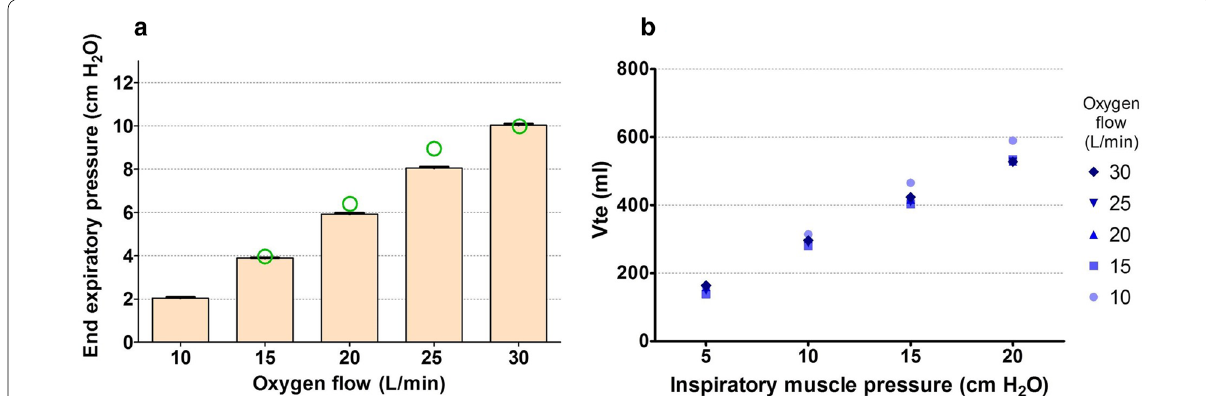
Fig. 1 Bench study and physiological measurements. Changes in pressure and volume related to the oxygen flow rate. a Mean (bar chart) standard deviation (error bar) of end expiratory pressure recorded on the oro‑nasal mask of Boussignac FF‑CPAP assembled with the DAR ± filter (see text), obtained at five constant oxygen flow rates (10, 15, 20, 25, and 30 L/min) at four simulated inspiratory efforts (from weak to strong). Irrespective of the simulated respiratory effort, the observed end expiratory pressure on the mask was at 2, 4, 6, 8, and 10 cm H 2 O approximately, for oxygen flow of 10, 15, 20, 25, and 30 L/min, respectively. Green circles denote mean values recorded in four COVID‑19 patients. b Tidal volume recorded for each combination of simulated inspiratory effort and constant oxygen flow. Tidal volume variations depended on simulated